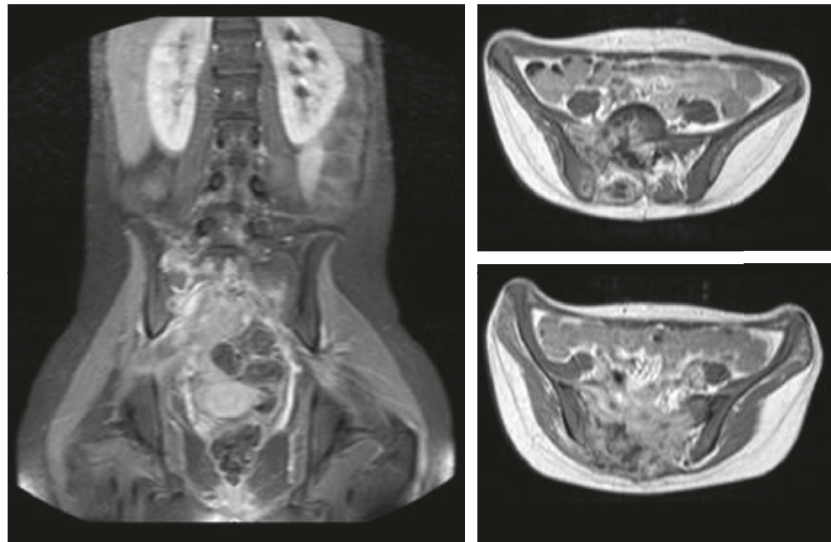
Figure 1: Selection of characteristic coronal and axial T1-weighted MRI slices of the Ewing Sarcoma.